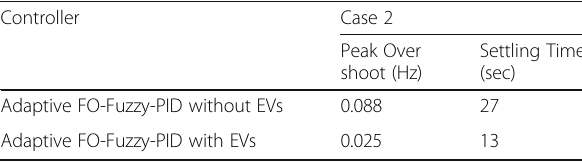
Table 3 Dynamic performance of the proposed controller with & without EVs